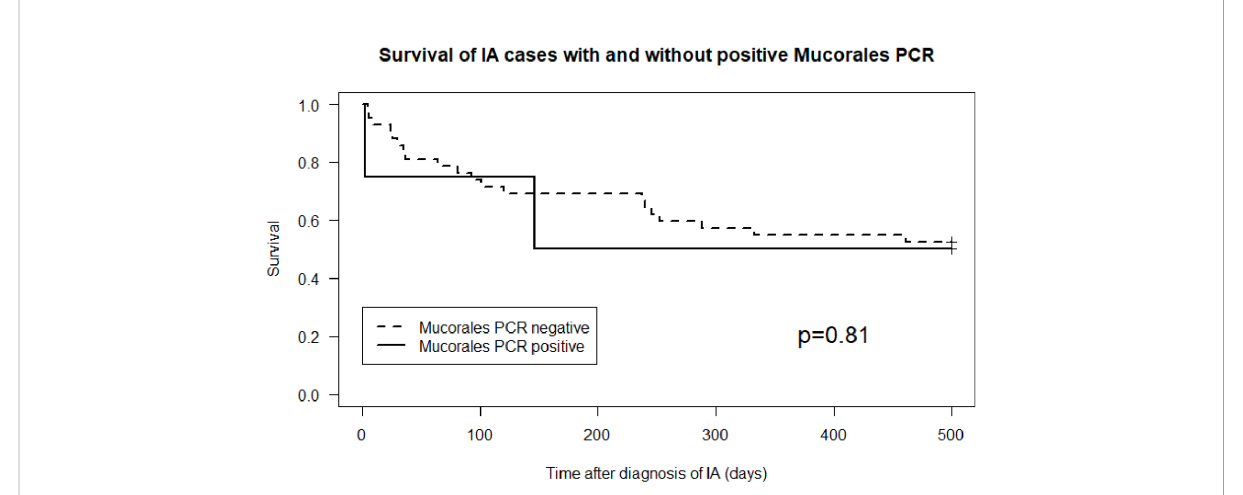
FIGURE 2 Cumulative survival in cases of invasive aspergillosis with versus without a positive Mucorales PCR (p=0.81).